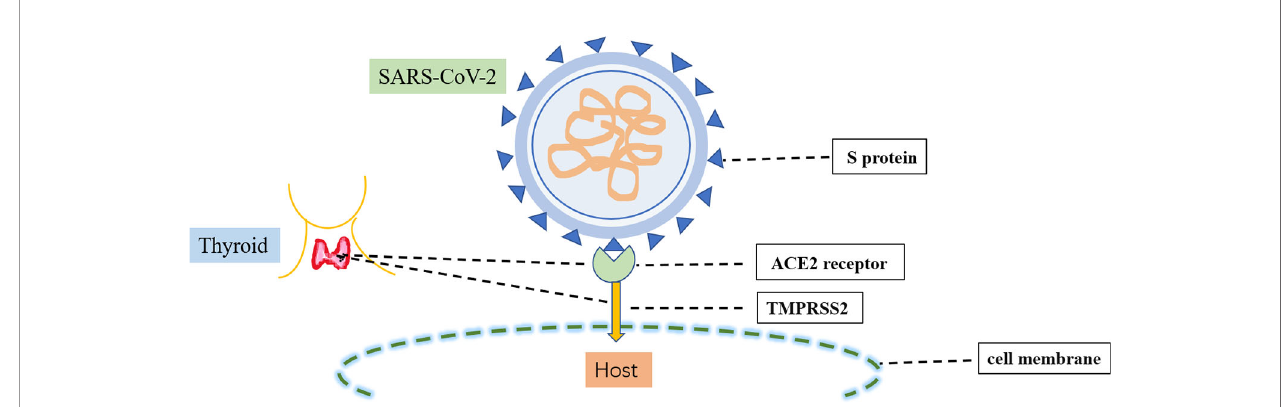
FIGURE 2 | Infection process of SARS-CoV-2. SARS-CoV-2 infection involves two crucial steps: the initial recognition of the receptor angiotensin-converting enzyme 2 (ACE2) via S protein and then the effective fusion of the cell membrane via transmembrane protease serine 2 (TMPRSS2). Both ACE2 and TMPRSS22 are highly expressed in the thyroid.